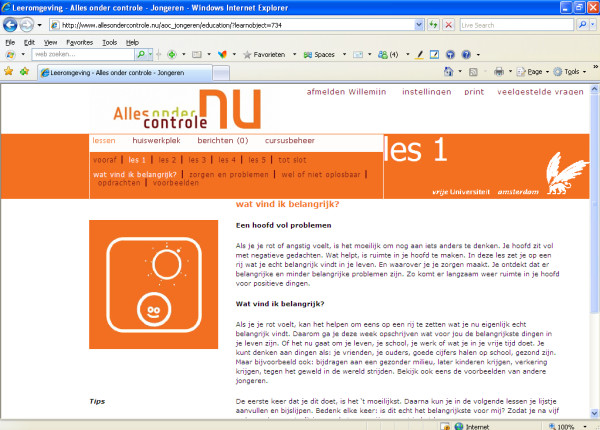
Printscreen website.